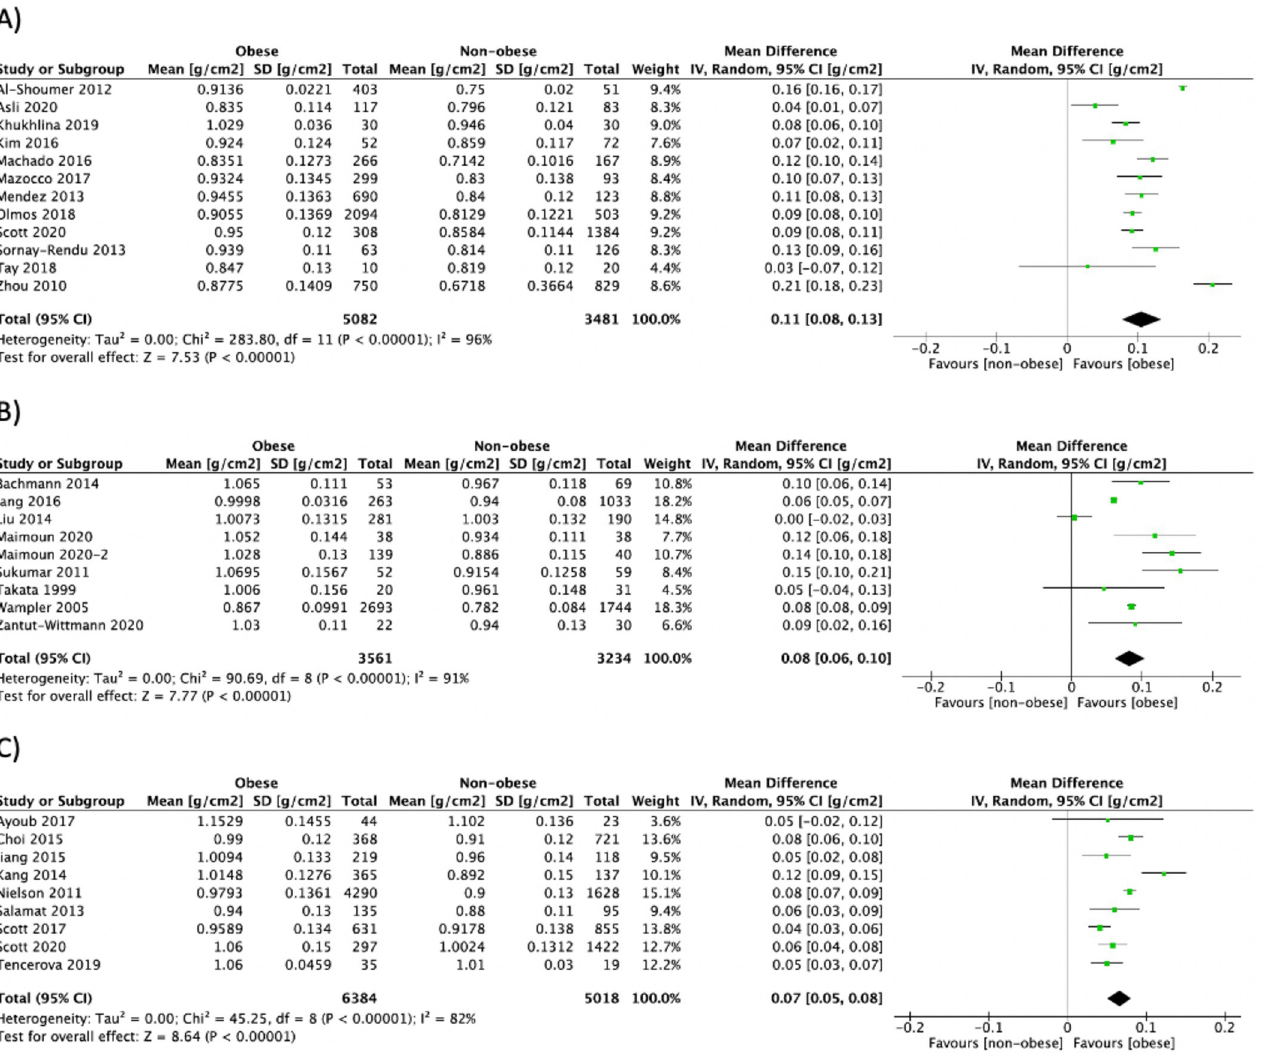
Fig 4. Forest plot of pooled effect size for the total hip aBMD by DXA mean difference between A) postmenopausal women, B) premenopausal women and C) men with vs. without obesity, using a random-effect model.